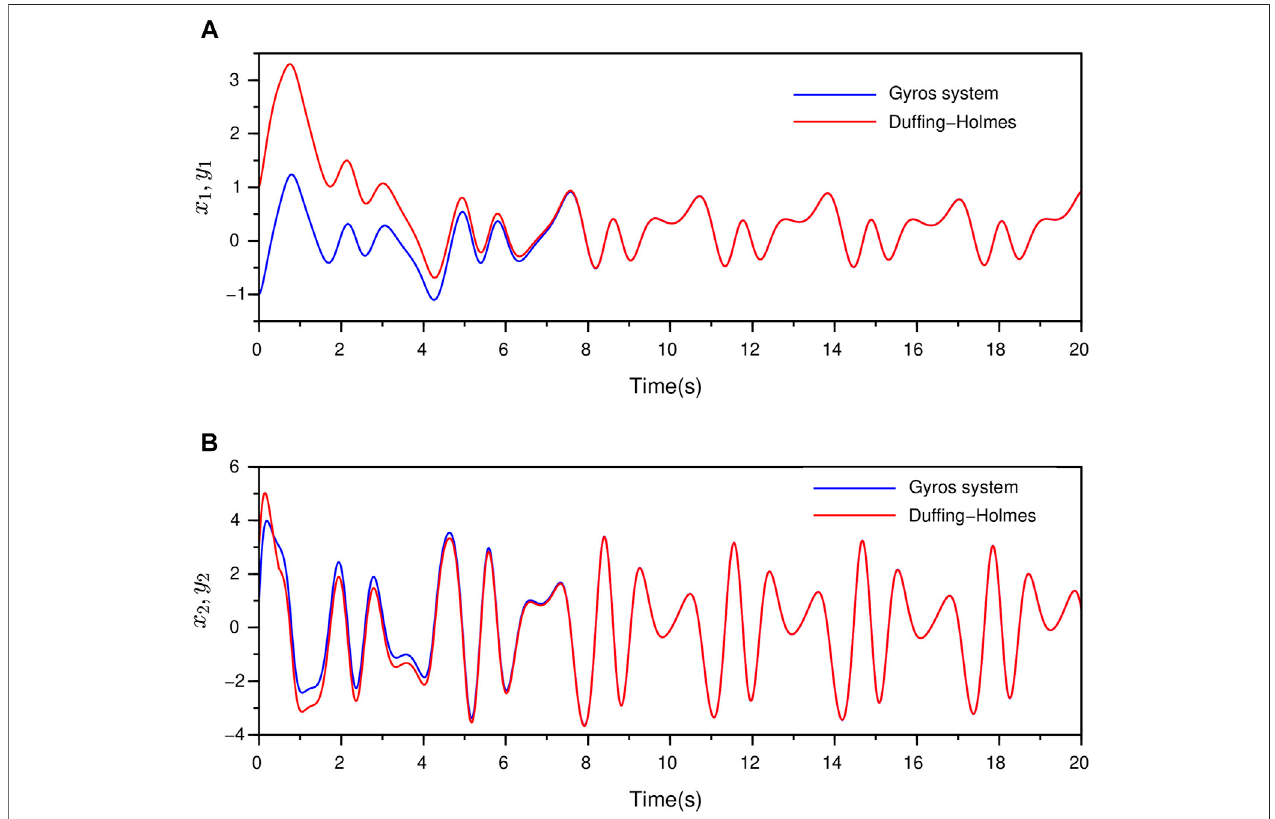
FIGURE 3 | Synchronization between the Gyros and the Duf fi ng-Holmes systems in Example 1 by NTSM controller (A) the synchronization between x 1 and y 1 (B) the synchronization between x 2 and y 2 .